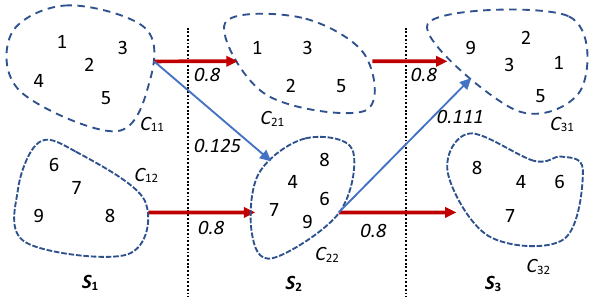
Fig. 4 The temporal evolutionary graph. The weight of each edge shows the overlap between two clusters. The red edge indicates two closest clusters between two